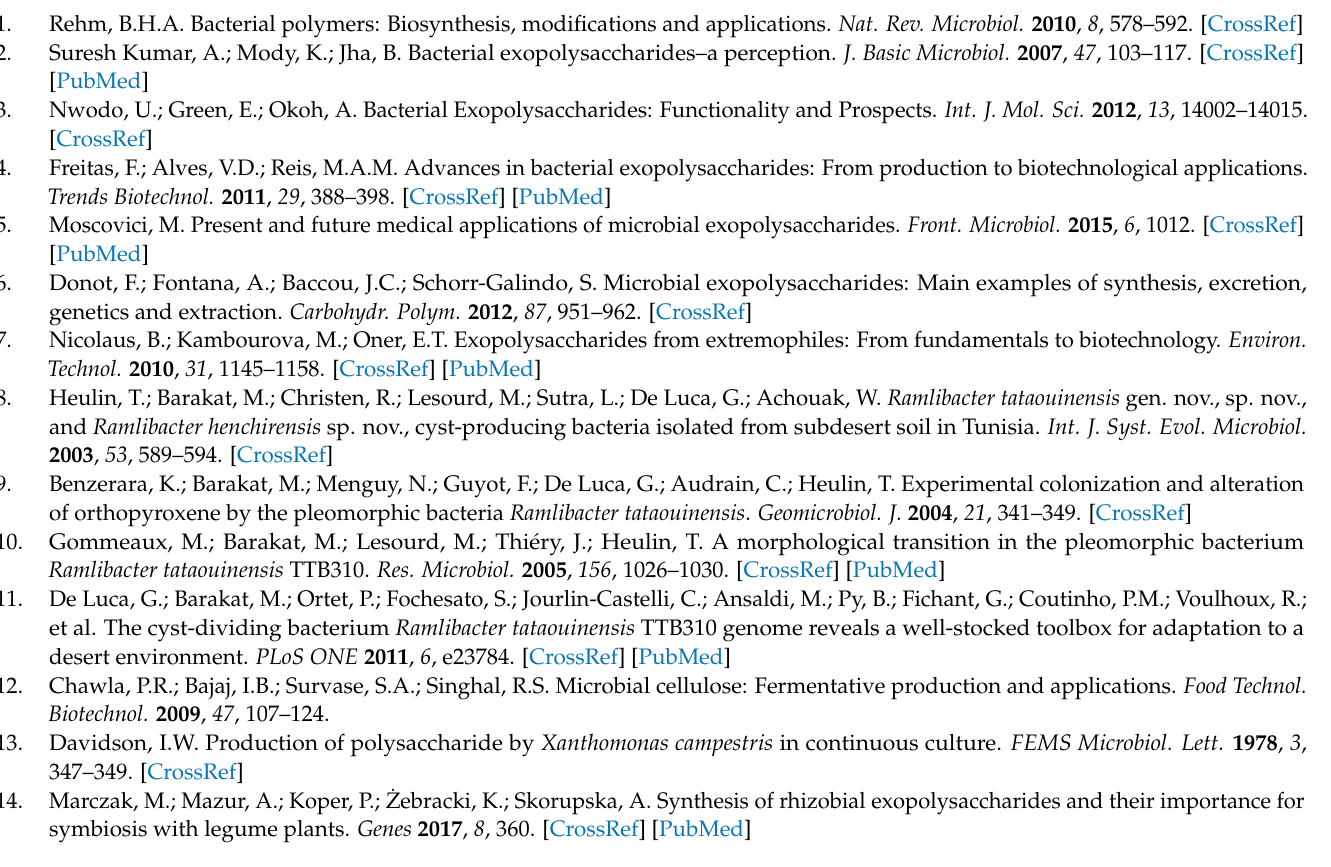
O 2 CH within carbohydrates. Table S1. Acquisition parameters of NMR spectra, shown according to figures. Table S2. Ions characteristic of monosaccharides. Table S3. Loss of mass corresponding to fragmentations of monosaccharides. Table S4. Use of an m / z distance matrix to search for char- acteristic mass losses of mono- and oligosaccharides. Table S5. Attribution of potential structures corresponding to m / z and loss of mass between signals. Table S6. Summary of potential structures and number of fragments indicative of these structures. Table S7. 1 H and 13 C NMR chemical shifts 1 H, 13 C HSQC cross peaks of the EPS of R. tataouinensis δ H/C of major